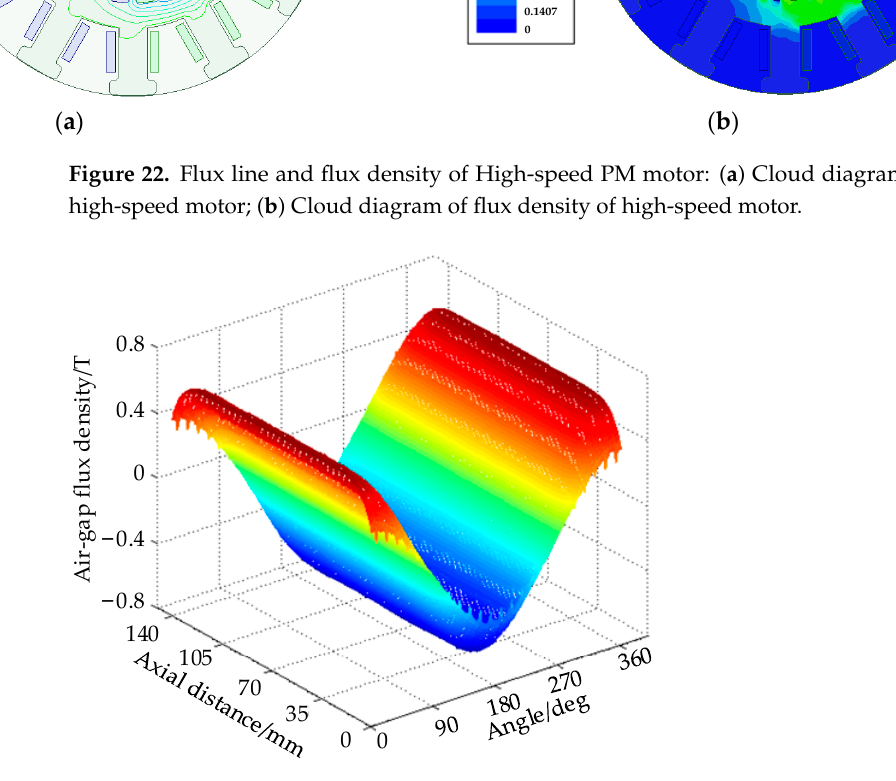
Figure 23. 3D diagram of Air gap flux density.